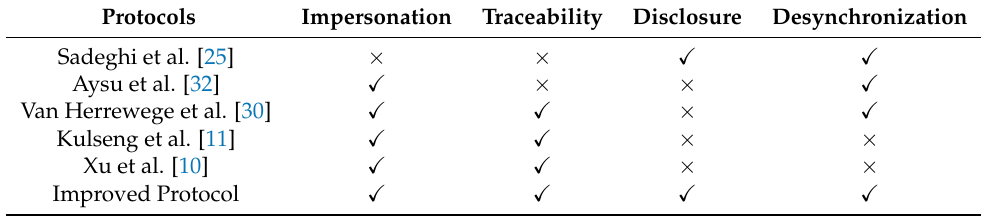
Table 3. The security comparison of the improved protocol to other protocols against IoT